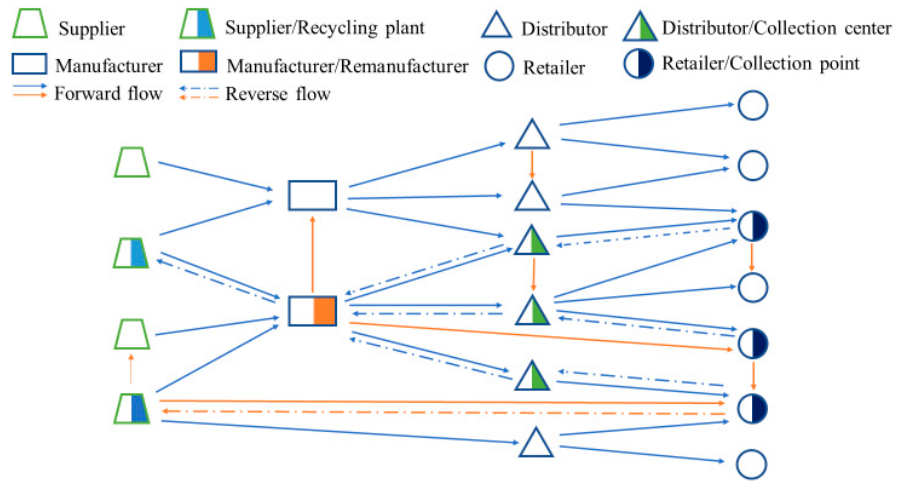
Figure 1. An illustration of a closed-loop supply network (CLSN).